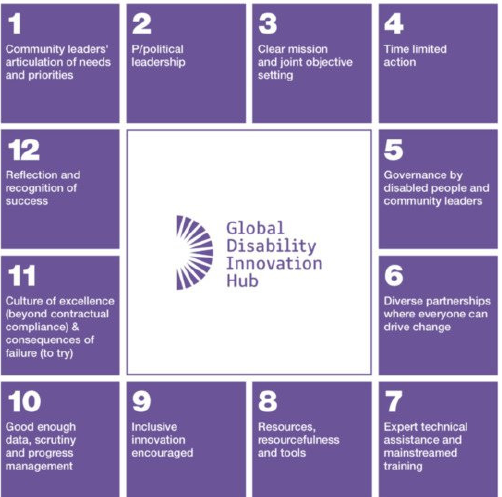
Figure 1. 12-step framework for delivering disability inclusion in London 2012. Taken from [23].